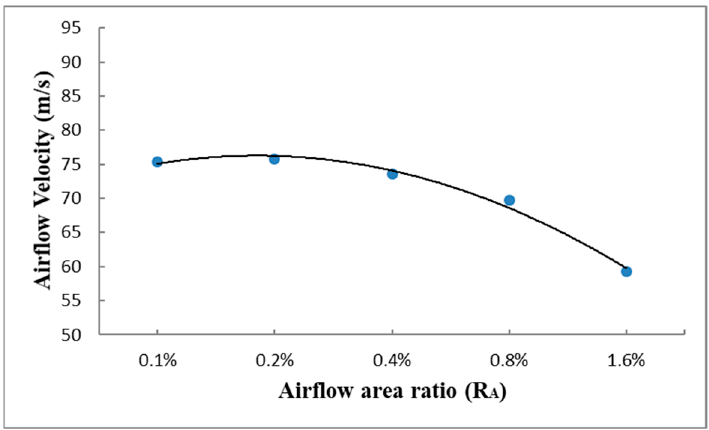
Figure 10. Airflow velocity corresponding to area ratio of orifice cross-section R A.